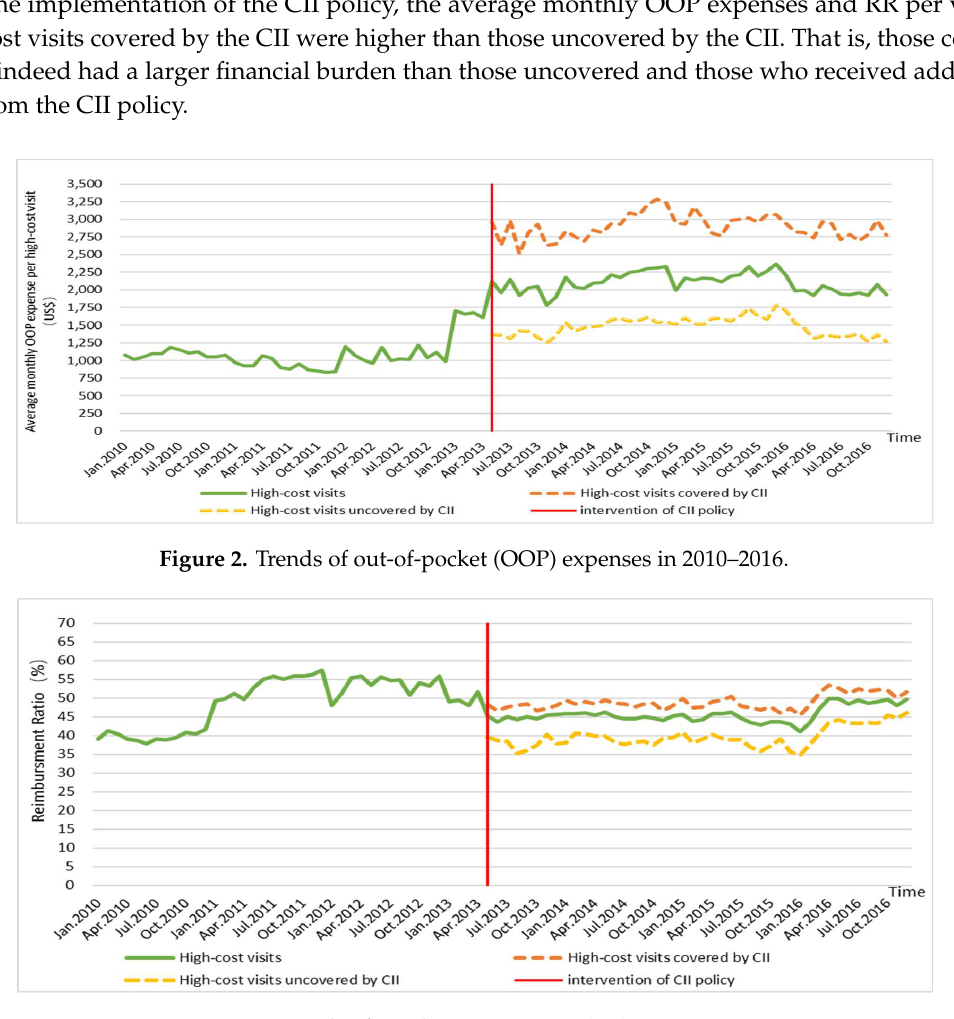
Figure 3. Trends of reimbursement ratio (RR) in 2010–2016.